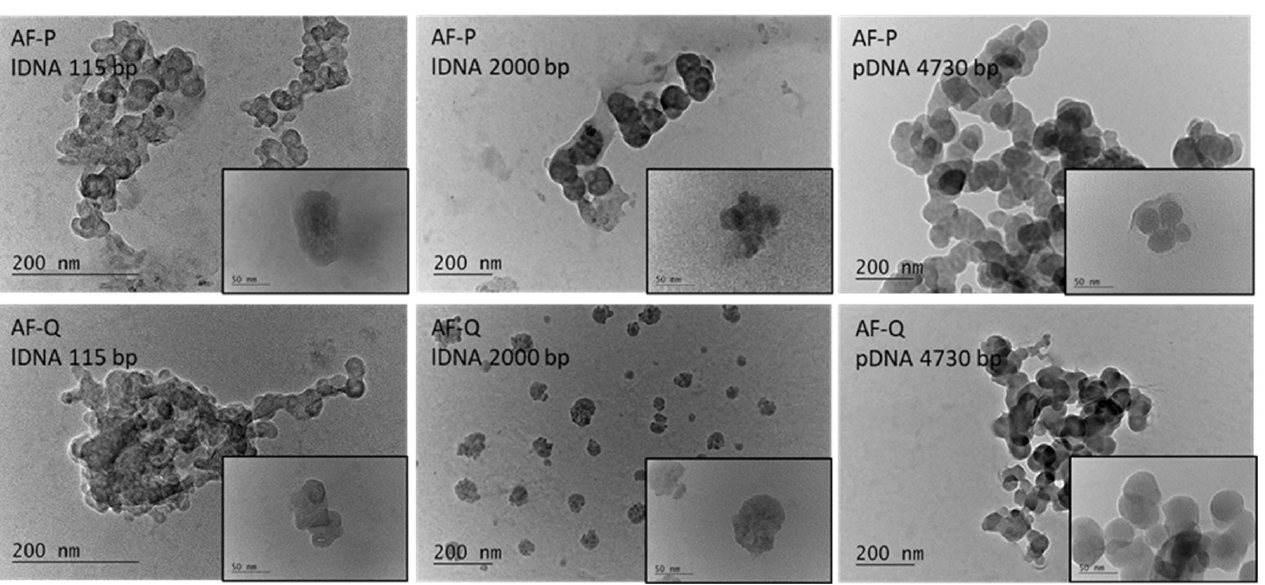
Figure 4. TEM micrographs of polyplexes based on PDMAEMA star–shaped polymers prepared at N/P ratio of 8. Scale bars of the insets 50 nm.